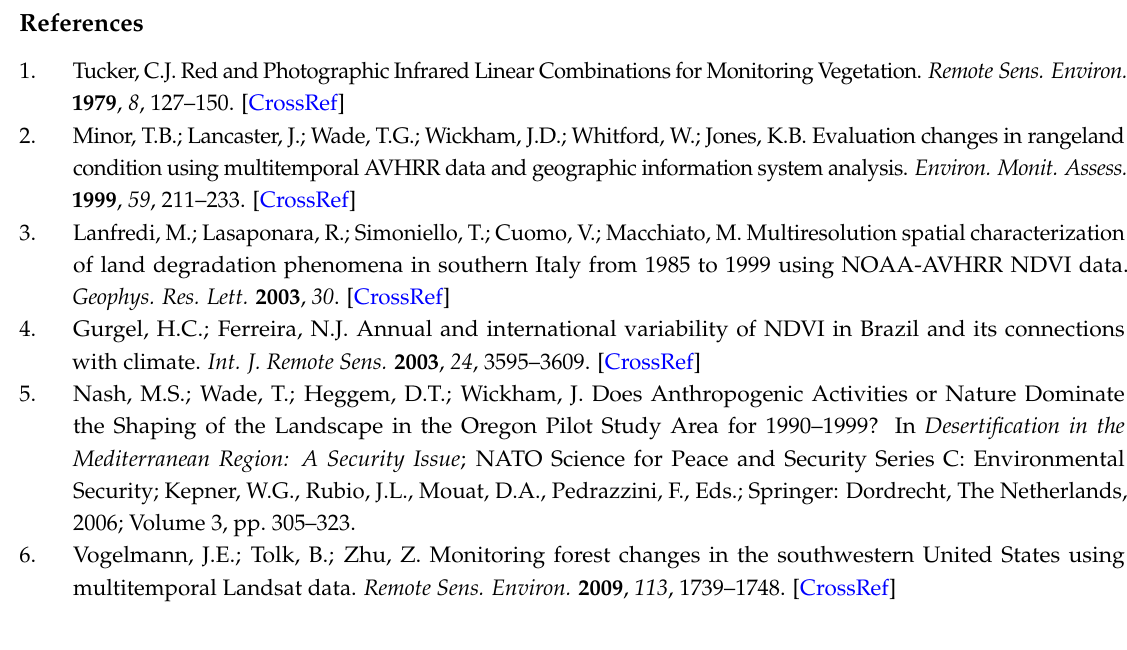
Table S1: Statistical summary for the trend values per outcome. Outcomes A and C denote changes due to direct factors, Outcome B denotes changes due to climatic factors, and Outcome D denotes no change in greenness. S denotes significant, u denotes univariate, m denotes multivariate, n denotes not. Percent (%) is the proportion of outcomes as described in Table 3. Table S2: Trend value, trend direction and the significant p-value for the climatic factors from the univariate autoregression (Equation (1)). The last two rows present NDVI trend, direction and p-value from univariate, and multivariate models. Figure S1: Land cover for the conterminous US. Data from National Land Cover Database (Fry et al., 2011). Figure S2: Observed and predicted values for NDVI for one pixel in the Yellowstone Fire (pixel A in Figure 6). The blue line is the observed values ( n = 300). The red line is the predicted values from the multivariate autoregression model and the green line represent the structural part of the multivariate autoregression model (see explanation for Equation (4)). NDVI trend with time ( β 6 = − 0.0604) is significant ( p < 0.0001). Figure S3: Observed and predicted values for NDVI for one pixel in the Yellowstone Fire (pixel B in Figure 6). The blue line is the observed values ( n = 300). The red line is the predicted values from the multivariate autoregression model and the green line represent the structural part of the multivariate autoregression model (see explanation for Equation (4)). NDVI trend with time ( β 6 = 0.0623) is significant ( p = 0.0002). Figure S4: Observed and predicted values for NDVI for one pixel within outcome B (see Figure 8). The blue line is the observed values ( n = 300). The red line is the predicted values from the univariate autoregression model and the green line represent the coefficient of time of the univariate autoregression model (see explanation for Equation (1)). NDVI trend with time ( θ 1 = 0.0276) is significant ( p < 0.0001). Figure S5: Observed and predicted values for NDVI for one pixel within outcome B (see Figure 8). The blue line is the observed values ( n = 300). The red line is the predicted values from the multivariate autoregression model and the green line represent the coefficient of time of the multivariate autoregression model (see explanation for Equation (4)). NDVI trend with time ( β 6 = 0.0281) is not significant ( p =